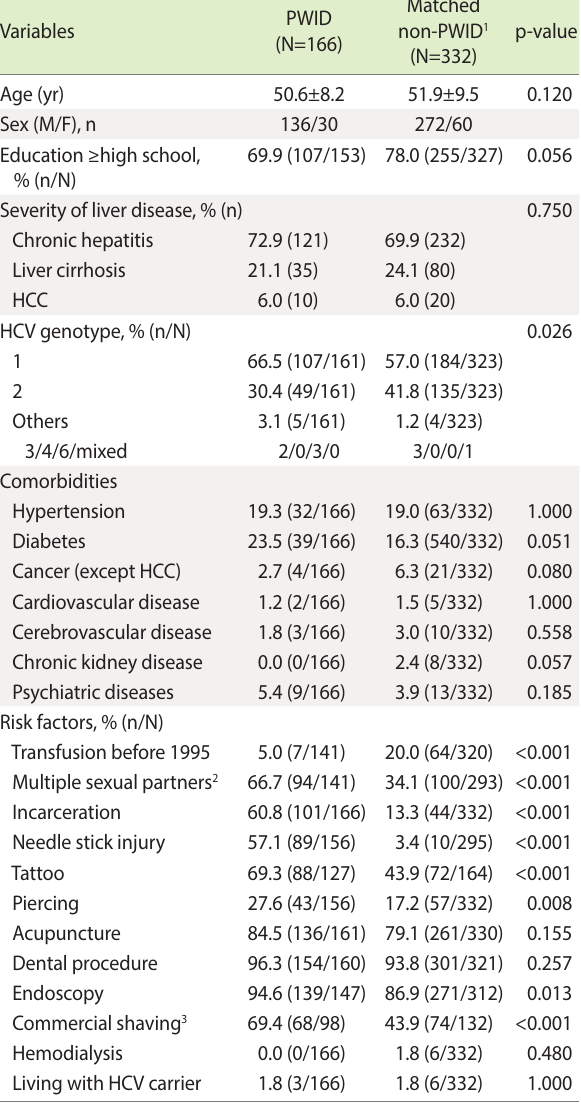
Table 2. Comparison of HCV infection status and comorbidities ac- cording to injection drug use Variables